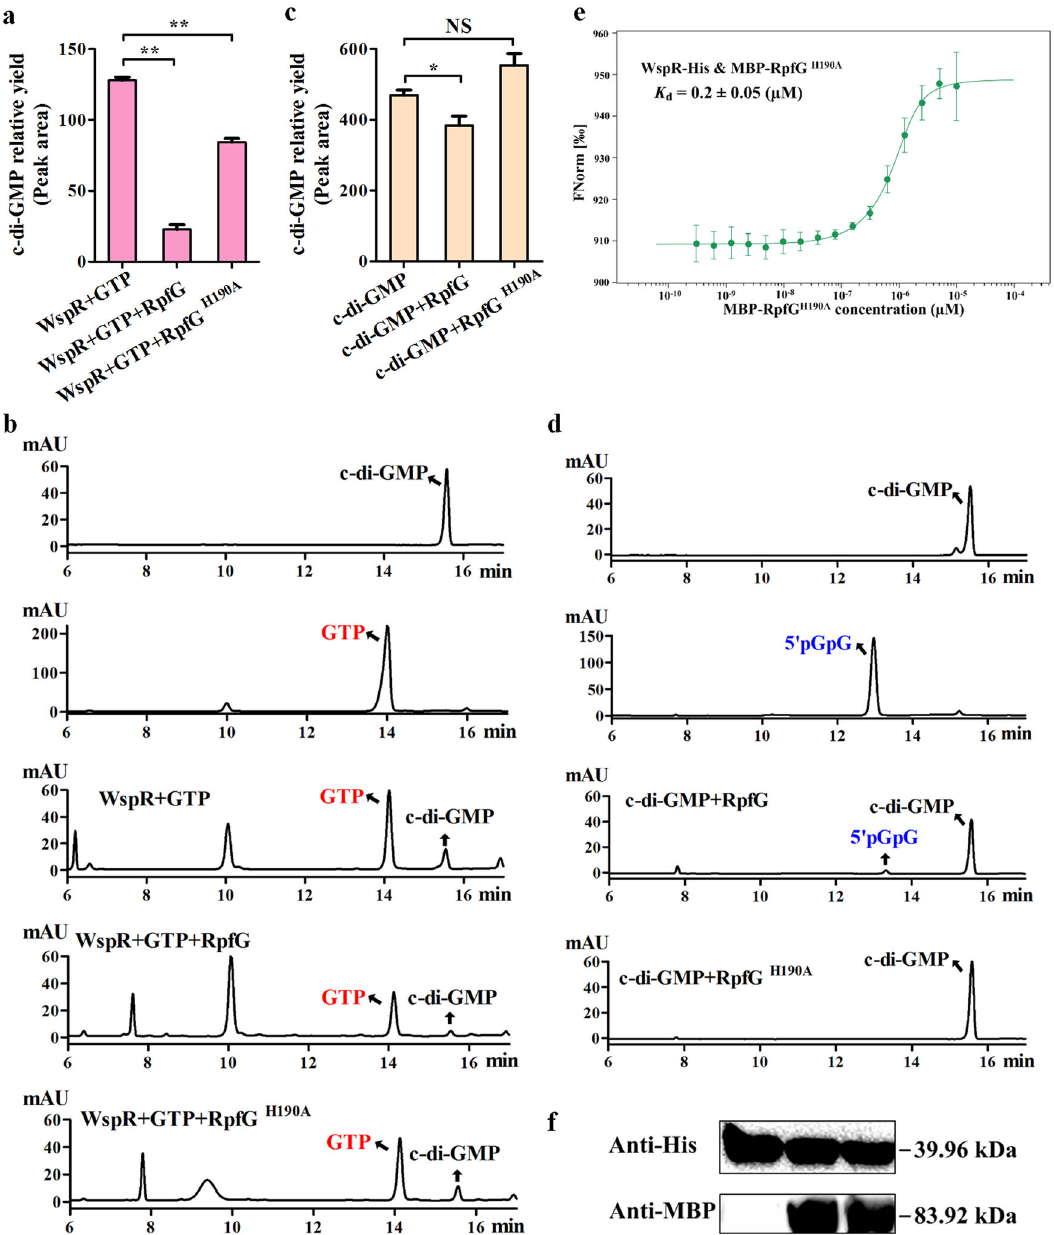
Fig. 5 Interaction with RpfG impaired DGC activity of unphosphorylated WspR. a Decreased c-di-GMP synthesis by puri fi ed WspR-His in the presence of MBP-RpfG or MBP-RpfG H190A using GTP as a substrate. The peak area of the HPLC chromatogram is expressed as the relative yield of c-di-GMP (y-axis). MBP-RpfG H190A represents an enzymatically inactive variant of MBP-RpfG. b HPLC chromatogram corresponding to a . The c-di-GMP and GTP standard are represented in black and red, respectively. c The puri fi ed MBP-RpfG still exhibited slight enzymatic activity against c-di-GMP in vitro, but not MBP-RpfG H190A . d HPLC chromatogram corresponding to c . The 5 ′ pGpG standard is represented in blue. e MST showing that WspR-His interacts with MBP-RpfG H190A with moderate af fi nity ( K d , 0.2 μ M). f Western blotting showing that the